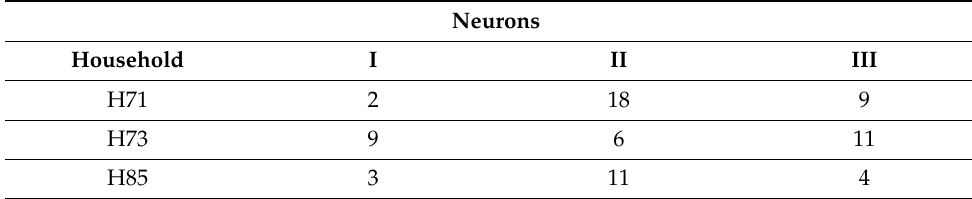
Table 3. Neurons of hidden